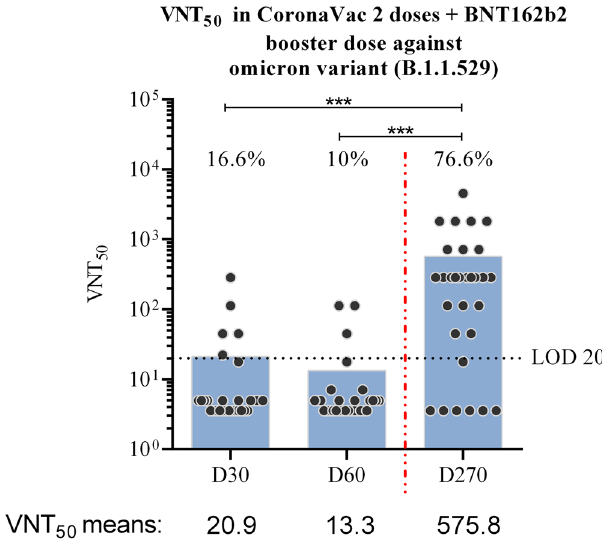
Fig. 1 Viral microneutralization assay against SARS-CoV-2 Omicron variant. Neutralizing antibody titers were determined using serum samples collected: 30 days after CoronaVac second dose (D30); 60 days after CoronaVac second dose (D60); 270 days after CoronaVac second dose and 30 days after BNT162b2 booster (D270). For each group, N = 30 biologically independent samples. The dark gray circles represent the included participants, and the 50% neutralizing titer (VNT 50 ) for each sample was assayed using the Omicron variant live virus (HIAE — W.A). The blue bars represent the VNT 50 mean values. The black dashed line represents the lower limit of detection (LOD), determined in this assay as 20, while red dashed line represents booster dose time point (D270). The percentage of seroconverted samples, for each group, is indicated in the graph. The statistical analysis was obtained by one-way ANOVA and Tukey ’ s multiple comparisons test, and the three asterisks represent the p value <